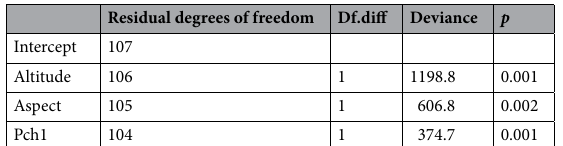
Table 2. Results of mvabund generalised linear model for pitfall traps grouped by altitude, aspect and sampling date.